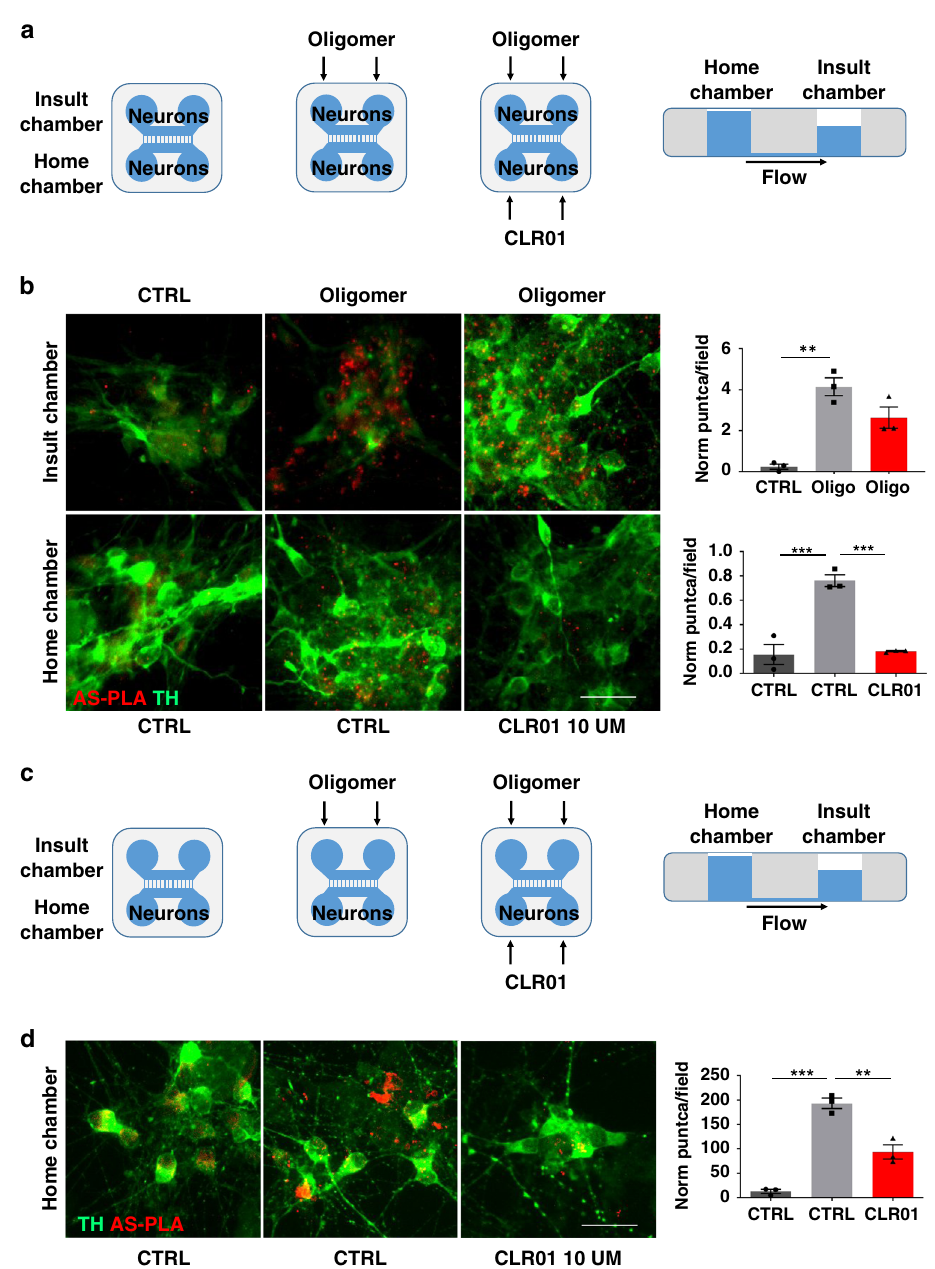
Fig. 2 CLR01 prevents α -syn aggregation in micro fl uidic chambers. a , c Schematic representation of the experimental design for the micro fl uidic-chamber experiments. b , d Representative immuno fl uorescence images of dopaminergic neurons grown in the micro fl uidic devices insulted with oligomers and/or treated with CLR01 for 5 days (25 µ g/ml and/or 10 µ M, respectively). Images were taken at least one fi eld of view away from the microgrooves to avoid artifacts due to contact with the silicone. Scale bars = 25 µ m. Quanti fi cation of normalized puncta per fi eld of three independent control cell lines analyzed using a one-way ANOVA (Tukey). Oligo: oligomer. b F(2, 6) = 24.31, p = 0.0009 and F(2, 6) = 39.09, p = 0.0005, p = 0.0006. d F(2, 6) = 71.45. * p < 0.05, ** p < 0.01, *** p < 0.001. For all appropriate panels, data are presented as mean values ±